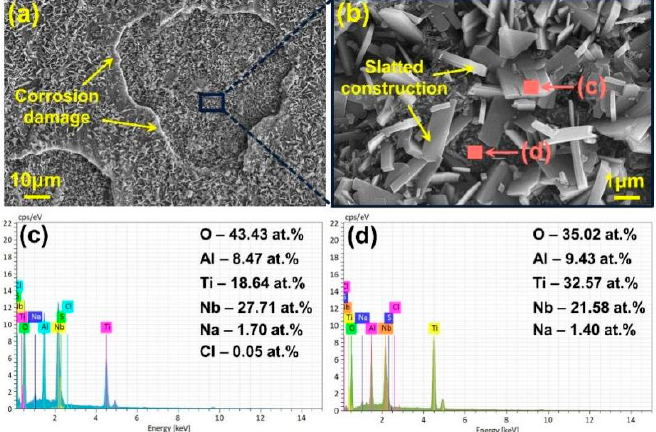
Figure 6. Surface SEM images and EDS spectra of the samples after alternating high temperature-salt spray test: ( a , b ) Microstructure of sample D3; ( c , d ) EDS analysis of sample D3.